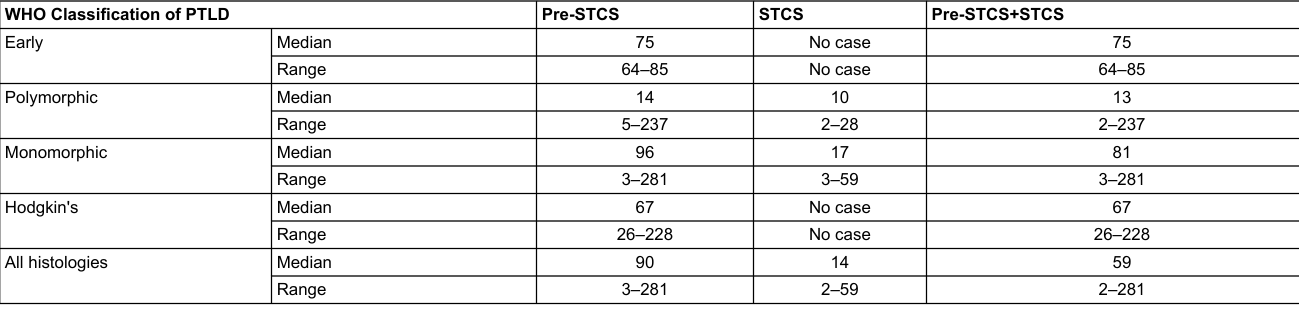
Table 1: Time from transplantation to post-transplant lymphoproliferative disorders (PTLD) diagnosis (months) with histological substratification. WHO Classification of